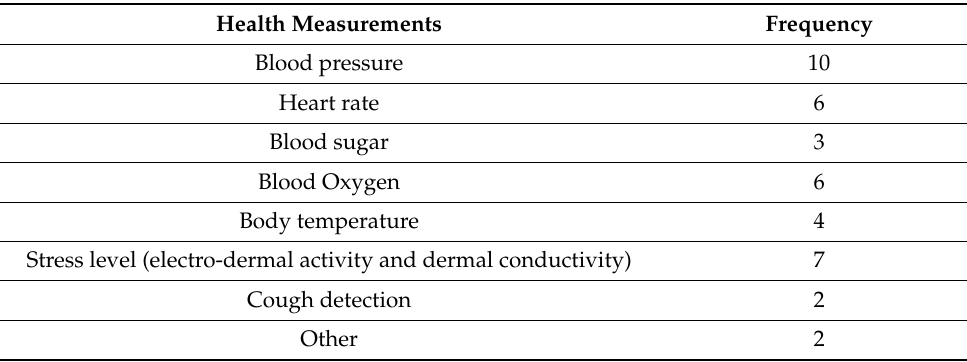
Table 14. Health measurements for monitoring (select multiple options allowed).